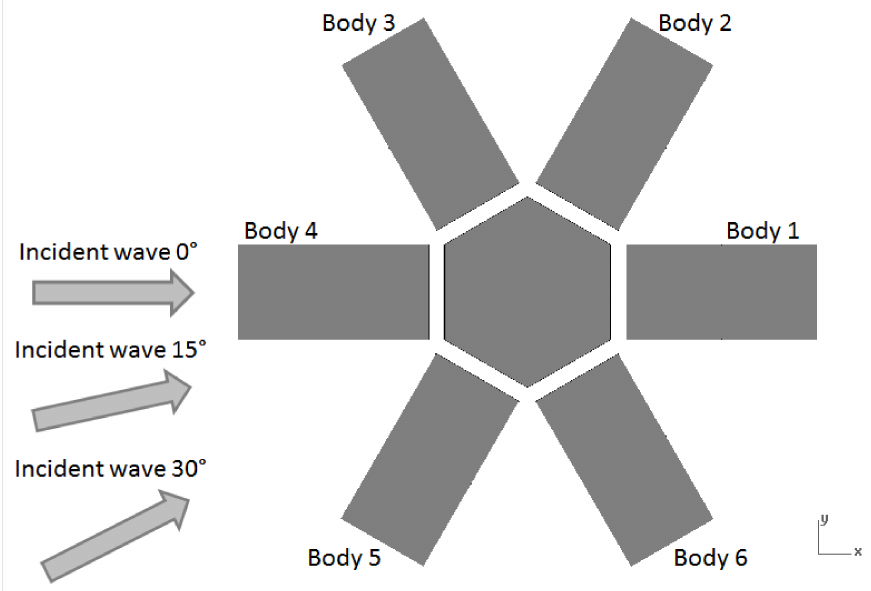
Figure 5. The analysed incident wave directions from a top view of the Nenuphar